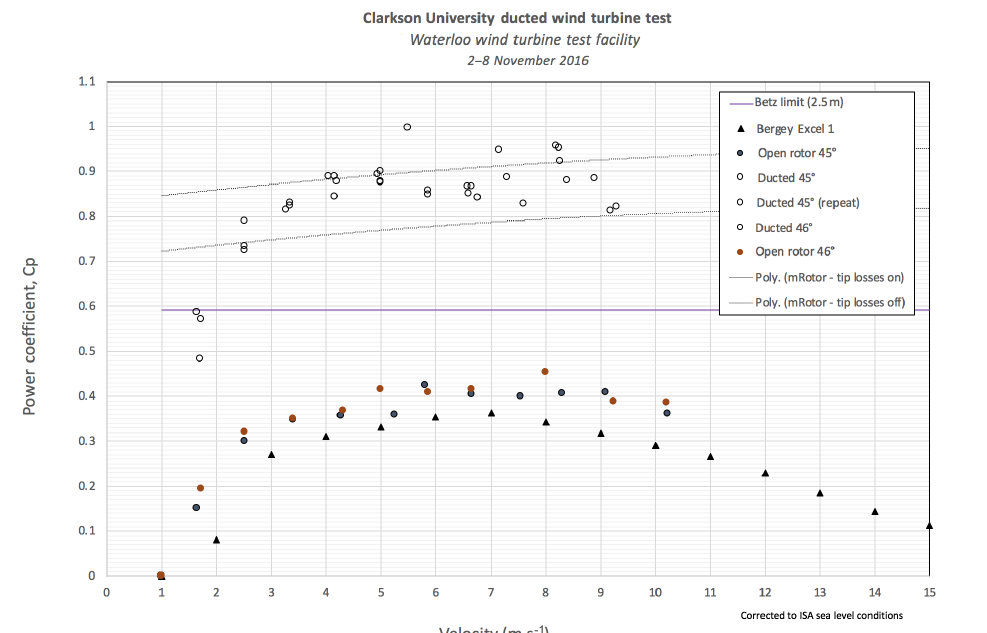
Figure 14. Experimental C p values (based on rotor area).